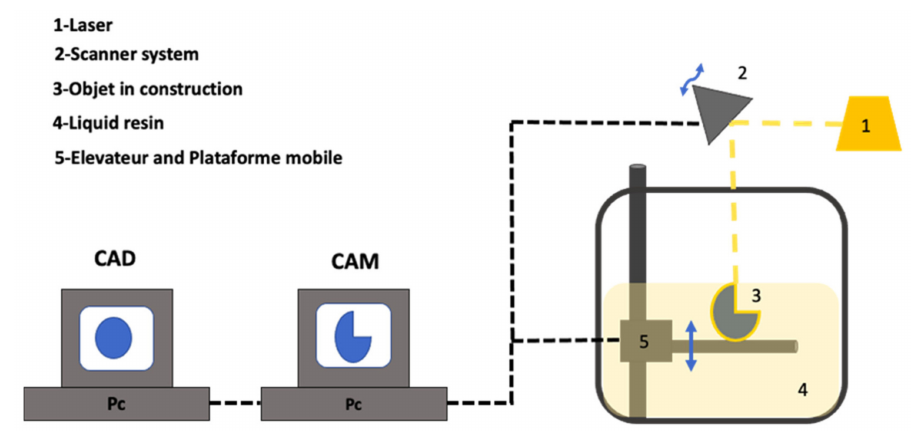
Figure 7. Stereolithography (SLA).